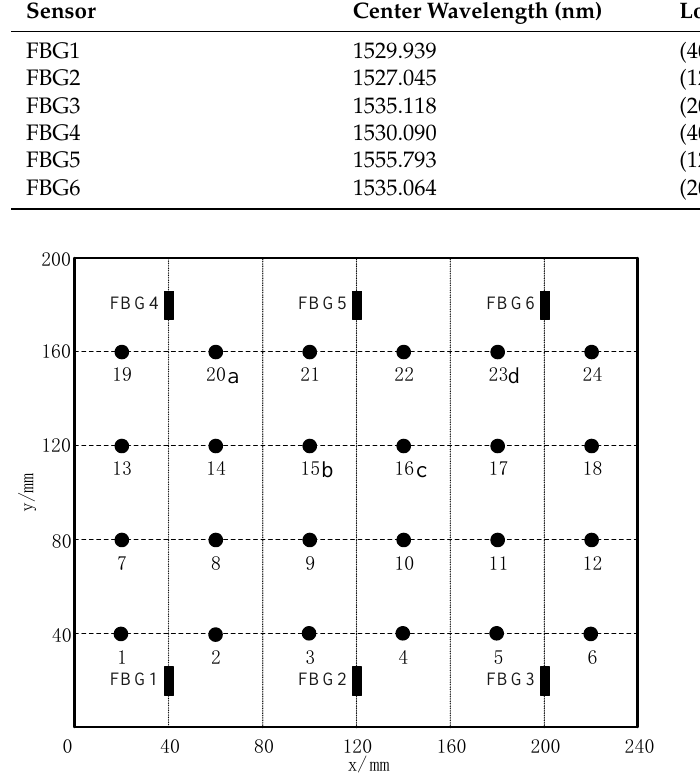
Figure 4. Impact point and sensor position